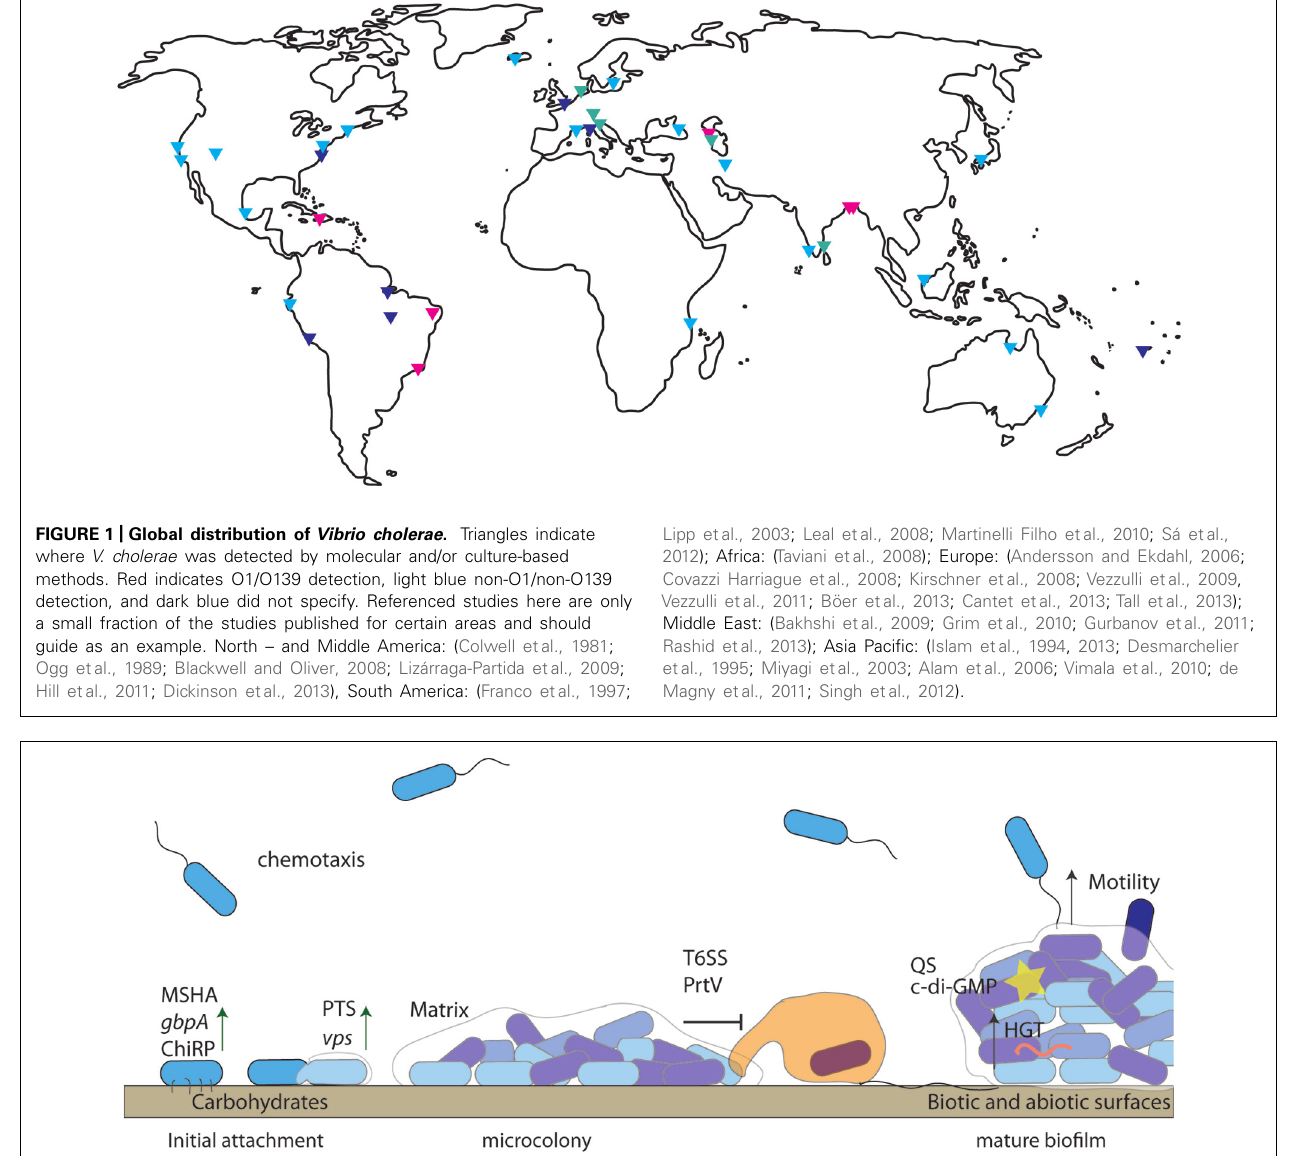
outer membrane proteins such as GbpA. Biofilm formation is re-enforced through the production ofVPS, which is controlled by QS (yellow star) and c-di-GMP. Anti-protozoal mechanisms such asT6SS protect surface attached bacteria. V. cholerae within biofilms undergo horizontal gene transfer (HGT), which may aid in